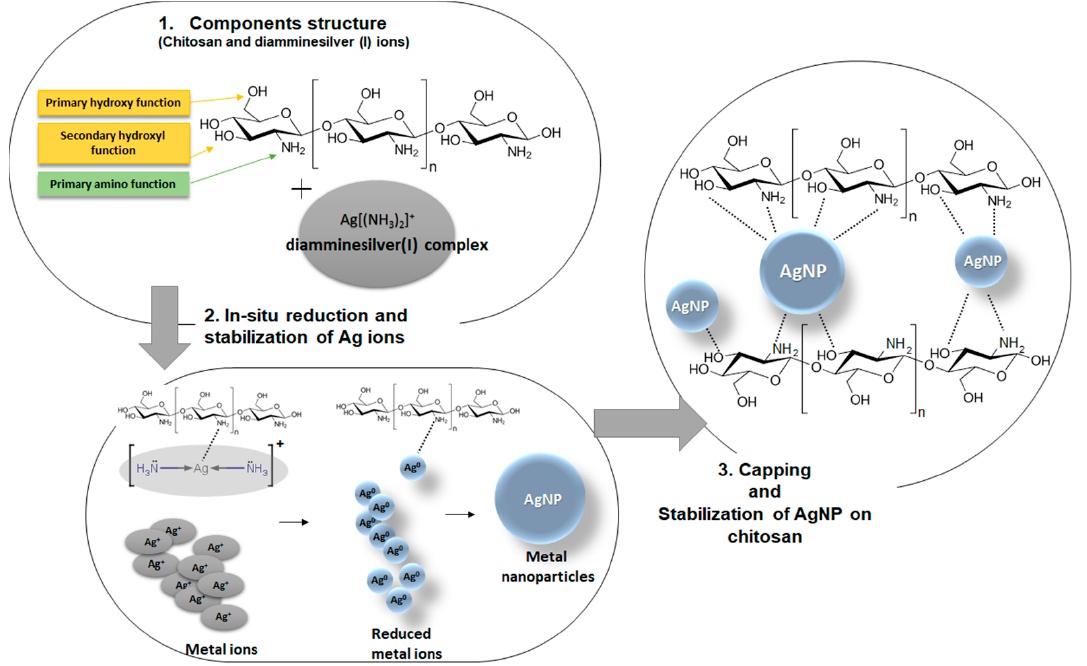
Figure 7. Schematic illustration of reduction and stabilization process of the diamminesilver(I) complex to AgNP by BP.